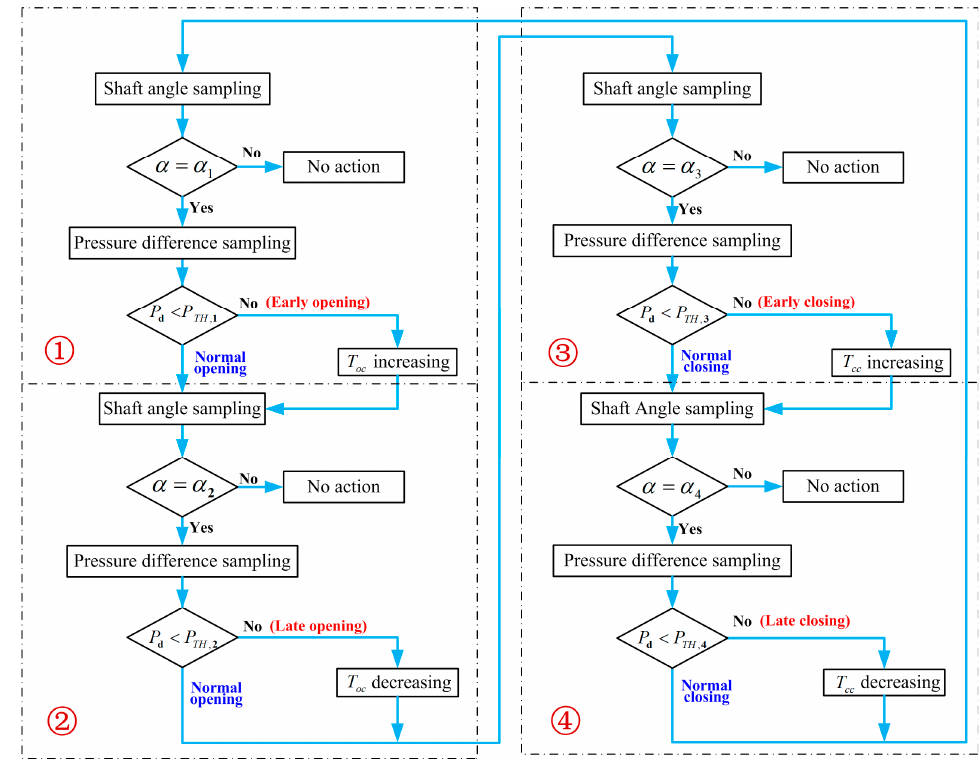
Figure 7. The flow chart for adaptive control of the FDV.